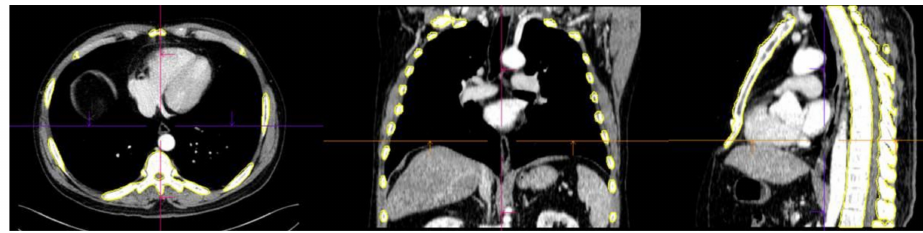
Figure 2. Segmentation of the axial skeleton.